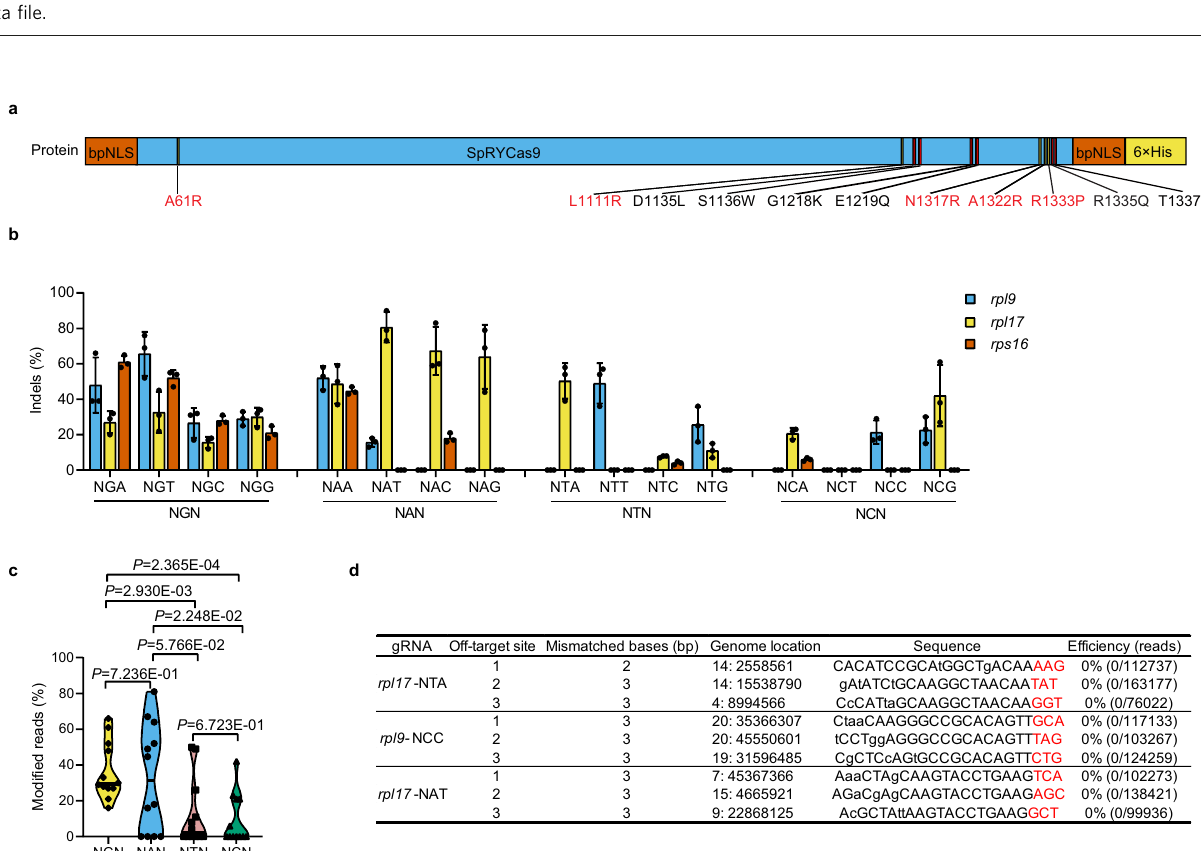
Fig. 1 Optimized SpGCas9 showed high editing ef fi ciency at NGN PAM sites in zebra fi sh. a Schematic illustration of codon-optimized SpGCas9 mRNA (zSpGCas9) and prokaryotic-expressed SpGCas9 protein. Six speci fi c amino acid mutations (D1135L, S1136W, G1218K, E1219Q, R1335Q, and T1337R) were introduced into the SpCas9 amino acid sequence to obtain SpGCas9. b Biallelic disruption of tyrosinase ( tyr ) by SpGCas9 generates mosaic pigmentation phenotypes. Lateral views of 2 dpf embryos are shown. The mosaic pigmentation degree (WT-like, mosaic 1, mosaic 2, albino) compared with wild-type (WT) is de fi ned in Supplementary Fig.3a. Scale bars: 1 mm. This experiment was repeated 3 times independently with similar results. c Phenotype statistics of embryos injected with SpCas9 mRNA/gRNA duplex, SpGCas9 mRNA/gRNA duplex, SpCas9: gRNA RNP complex, and SpGCas9: gRNA RNP complex. The stacked columns indicate the percentages of albino (white), mosaic 2 (light grey), mosaic 1 (medium grey), and WT-like (dark grey) zebra fi sh related to b . The total number of embryos was shown above each column. d Bar plot of indel ef fi ciency edited by SpGCas9 mRNA/gRNA duplex or SpGCas9: gRNA RNP complex containing IVT gRNAs (in vitro-transcribed gRNA) or EE gRNAs (EasyEdit gRNA) across tyr -NGG, rpl17 -NGA, rpl17 -NGT and rpl17 - NGC PAM sites. Editing ef fi ciency was assessed by targeted Sanger sequencing and ICE analysis (values are presented as mean value ± standard deviation (SD), n = 3 biological replicates). Data were analysed by two-tailed paired t test. * P ≤ 0.05, ** P ≤ 0.01, and *** P ≤ 0.001 (n.s. not signi fi cant). The exact P values are listed in Supplementary Data 6. e A schematic diagram of the sequence and secondary structure of EE gRNA loaded into SpGCas9 protein and bound to the genomic target site. The chemically modi fi ed nucleotides are labelled with black stars. f The editing ef fi ciency of SpGCas9 at 9 targets with NGH PAMs in the genes rpl9 , rps16 and ddx21 (values are presented as mean value ± standard deviation (SD), n = 3 biological replicates). g Assessment of the preference of SpGCas9-mediated mutagenesis for the last N of NGN PAMs using the violin plot. Each data point represents the averaged editing activity at the particular site. The centre line shows means of all data points. Two-tailed paired t test were performed (with P values marked). h Lateral views of SpGCas9: rpl17 EE gRNA (targeting NGA PAM) RNP complex induced mutated F0 at 3 dpf. Red arrows indicate the speci fi c features of rpl17 mutants. Scale bar: 1 mm. this experiment was repeated 3 times independently with similar results. All source data in this fi gure are provided as a Source data fi le.